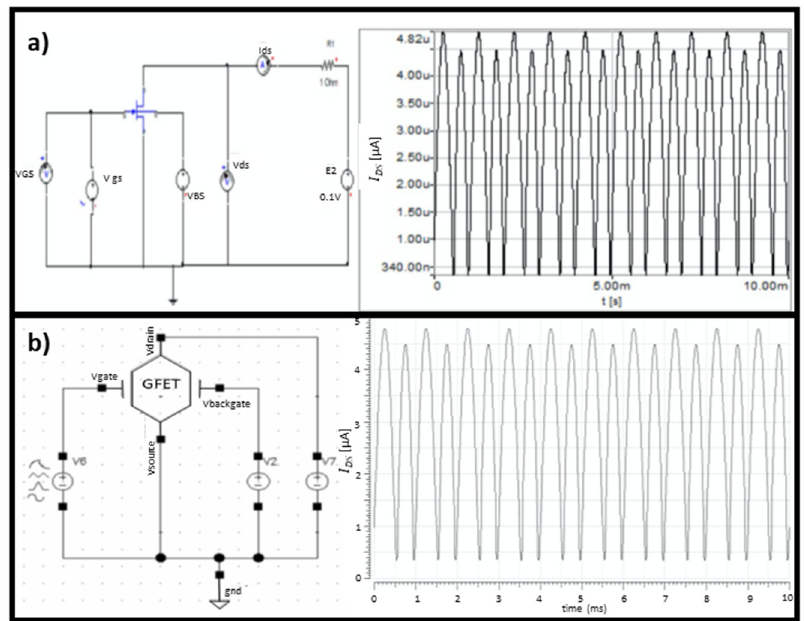
Figure 8. Frequency doubler simulated in ( a ) Simplorer and ( b ) Cadence. The graphs show the drain-to-source current output for a sine wave input (VGS) with a frequency of 1 kHz, an amplitude of 300 mV, and an offset of 4.9 V.